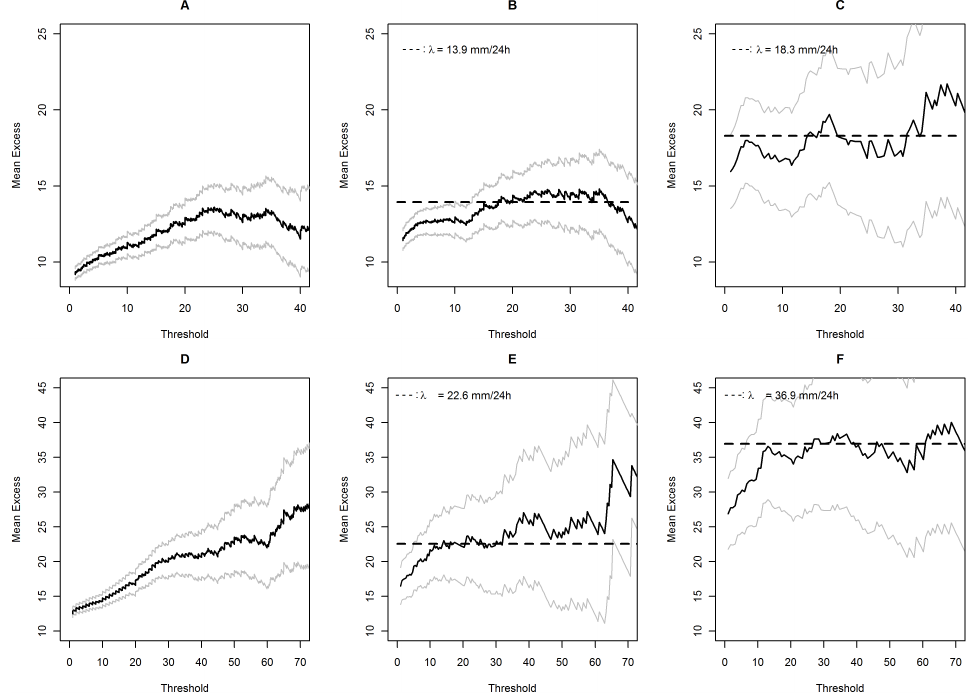
Fig. 6. MRL plot for all year ( A and D ), “season-at-risk” ( B and E ) and WP 4 days within “season-at-risk” ( C and F ) at Lyon rain gauge (A, B and C) and St Etienne en D´evoluy (D, E and F). Gray lines represent the 95% confidence interval. The dashed lines highlight the fitted value of the scale parameter according to an exponential